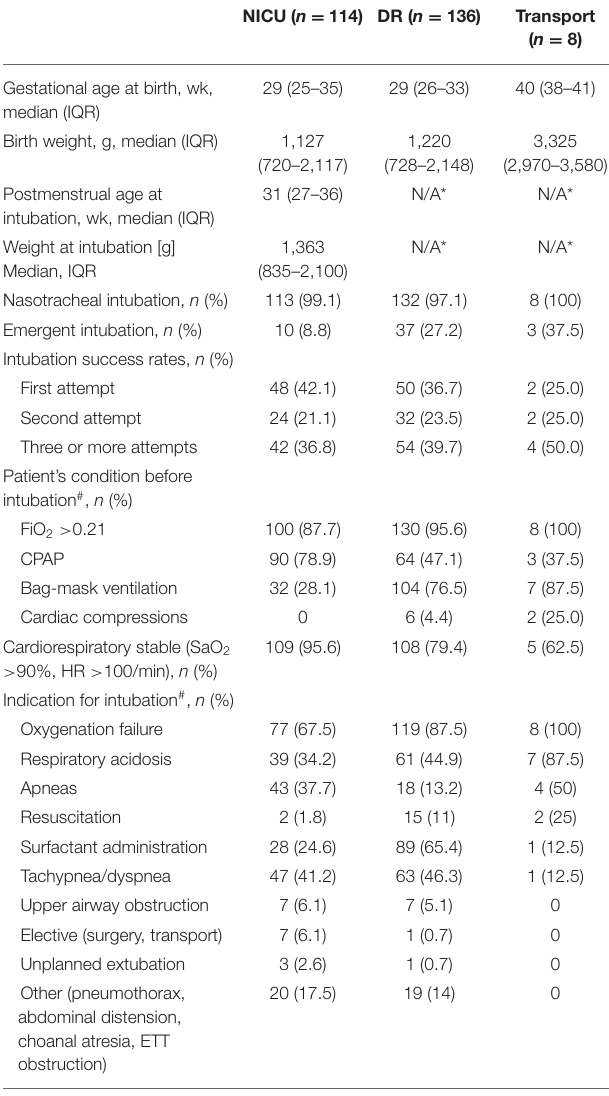
TABLE 1 | Characteristics of intubation